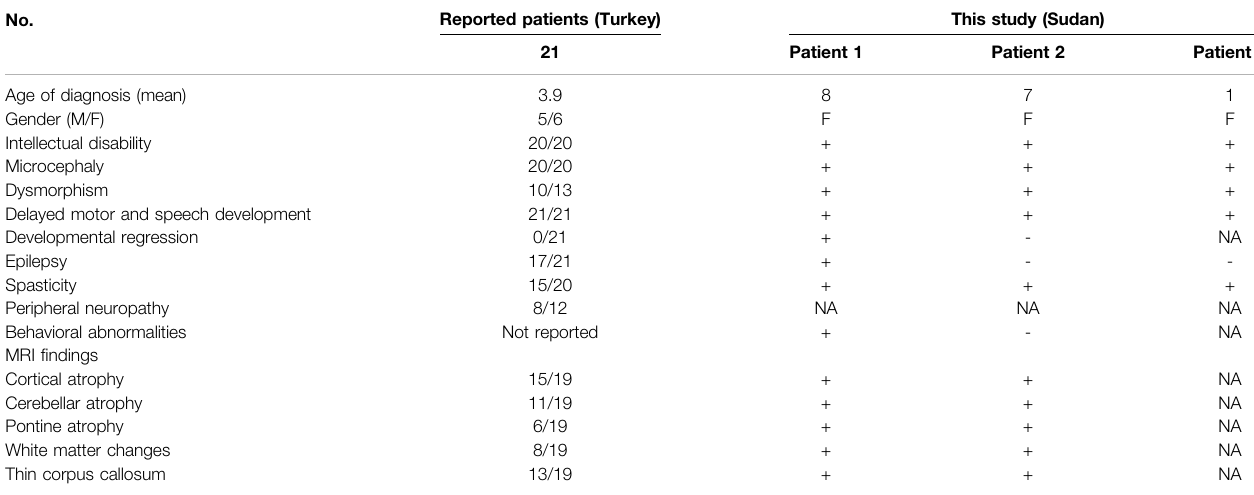
TABLE 1 | Clinical features of patients with CLP1 mutation. Reported patients (Turkey) This study